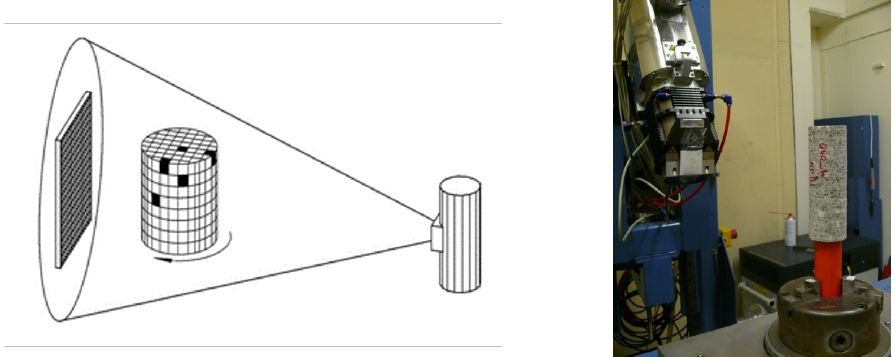
Figure 4. Schematic of the X-ray CT measurement principle ( left ) and photograph of the used CT system with SFRC sample placed on the rotating table ( right